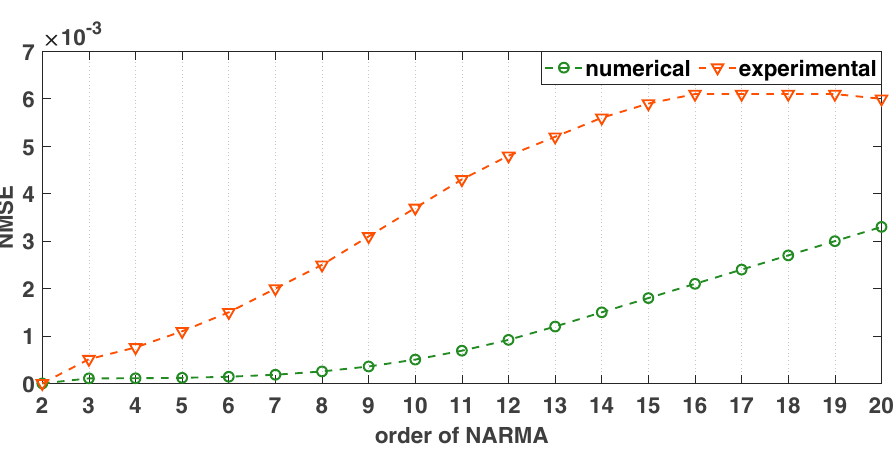
Figure 9. Comparison of the performance of the PRC for NARMA tasks. ( a ) Input function, u ( t ). ( b ) 2nd order NARMA task. Performance metric: NMSE exp = 2.8181 × 10 − 10th order NARMA task. NMSE exp = 0.0037 , NMSE sim = 5.0362 × 10 − NMSE exp = 0.0060 , NMSE sim = 0.0033 . Only a portion of the result is shown in each figure. Parameters were set such that: V µ = µ = 5 , A = 0.5 , � = 40 π rad/s, V ω 0 = ω 0 = 40 π , T p = 0.1 seconds, N = 1000 nodes, φ = π/ 3 rad, σ = 15 , β = 1.0 .